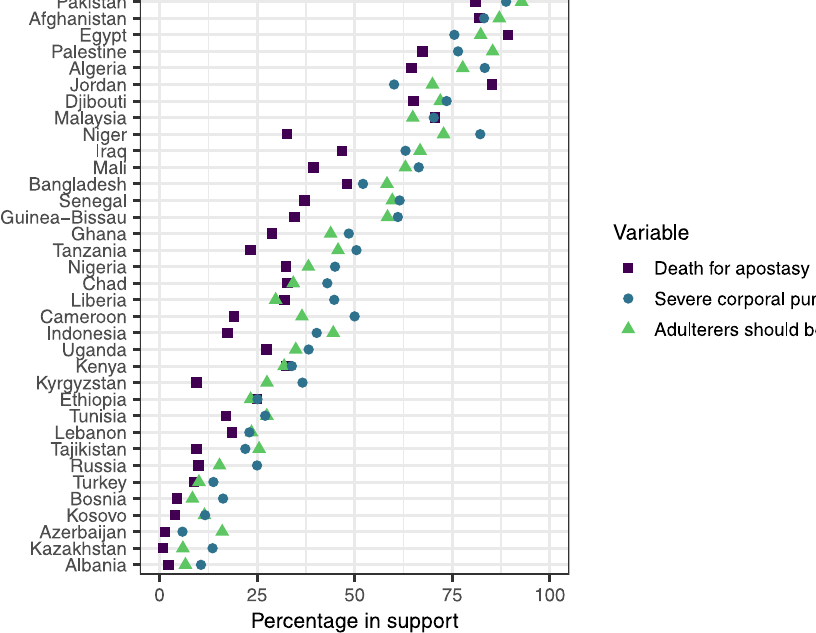
Fig 2. Dotplot of percentage of Muslim respondents who support three different questions measuring support for violent practices for the violation of norms. Countries are ordered from lowest to highest average level of support across all three